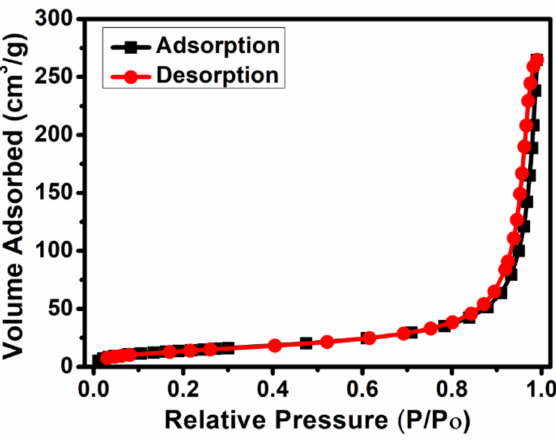
Figure 4. Nitrogen adsorption–desorption isotherm curve of CdS